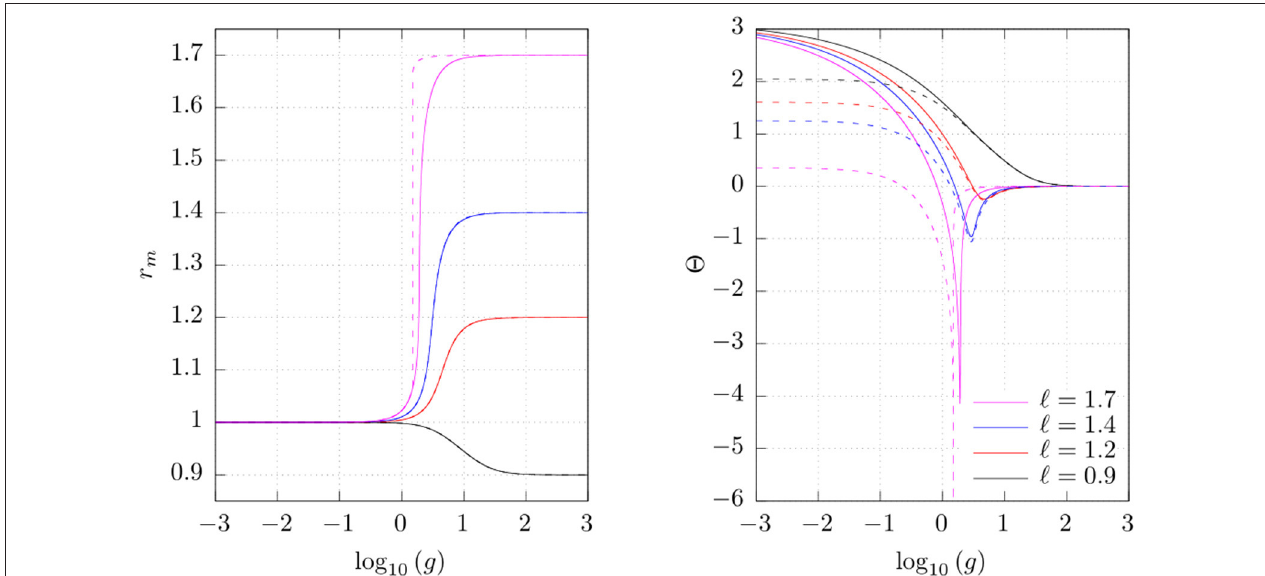
FIGURE 2 | The distance of closest approach, r m , and the scattering angle, 2 , from binary scattering of Lennard-Jones (solid lines) and Lennard-Jones/spline-particles (dashed lines) given as functions of the relative speed g for sampled values of the impact parameter ℓ .